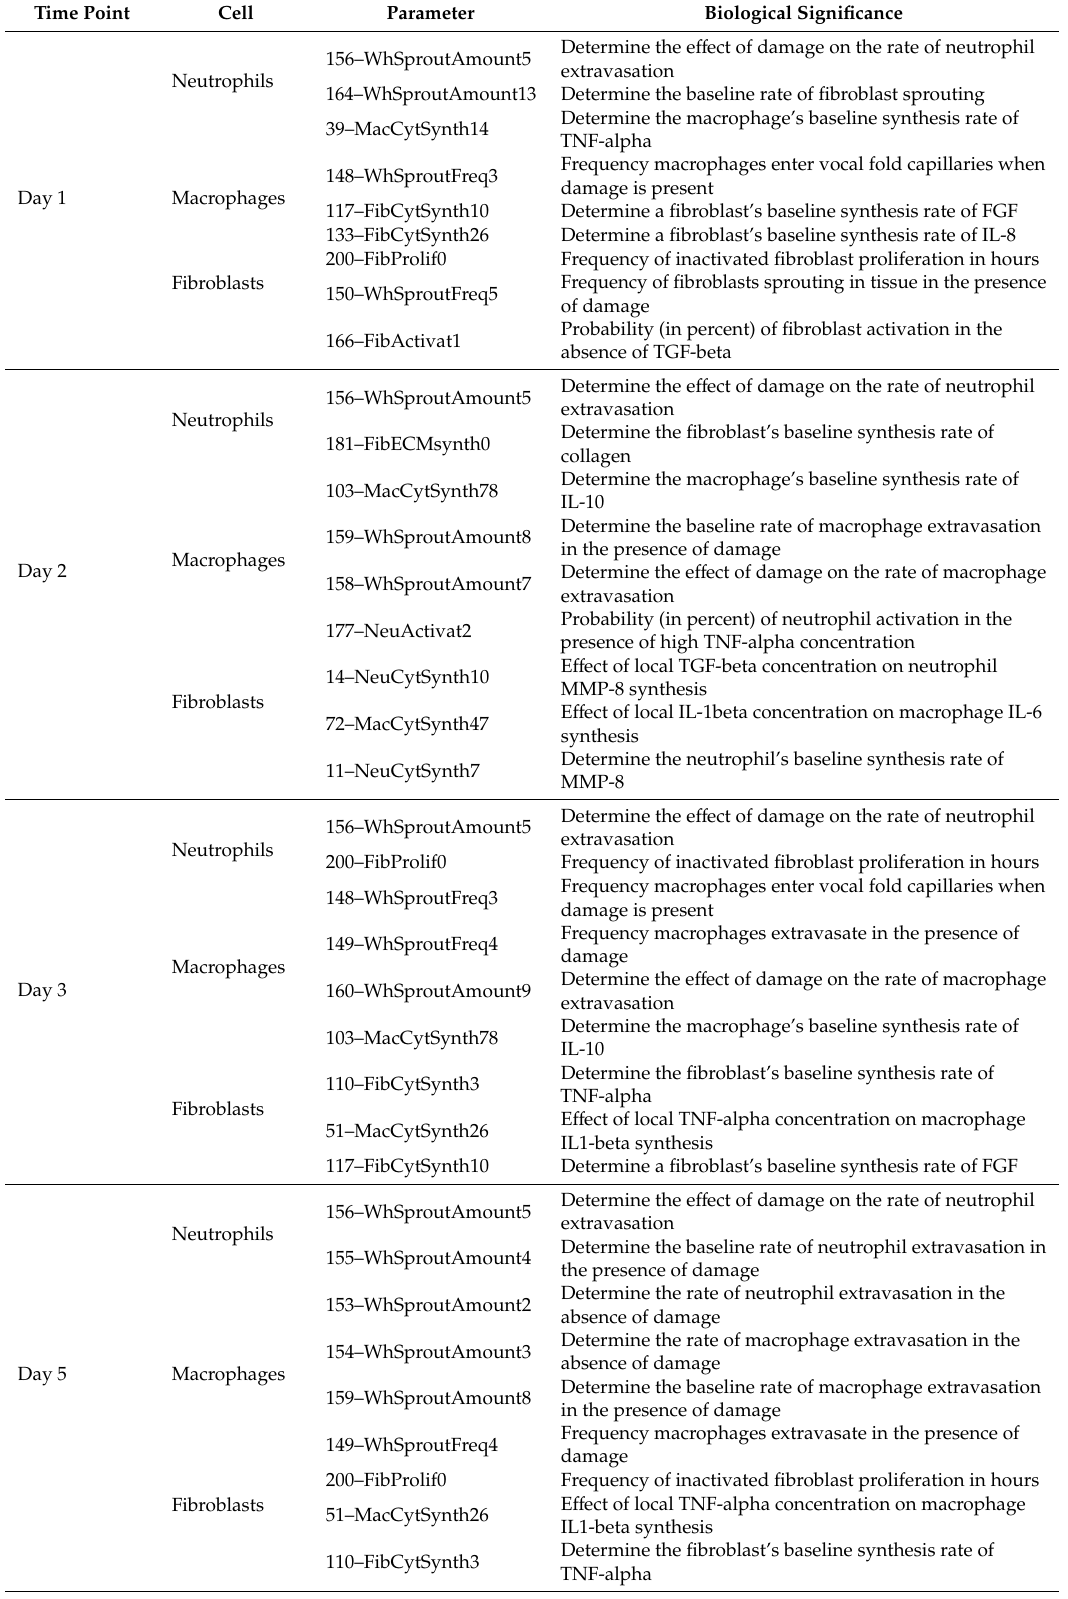
Table 5. Parameters used for model